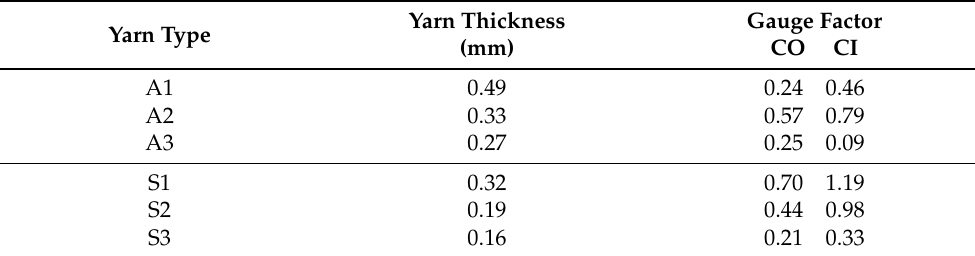
Table 4. The yarn thicknesses and electromechanical performance of sensors knitted with NP 9 and CI/CO configurations.